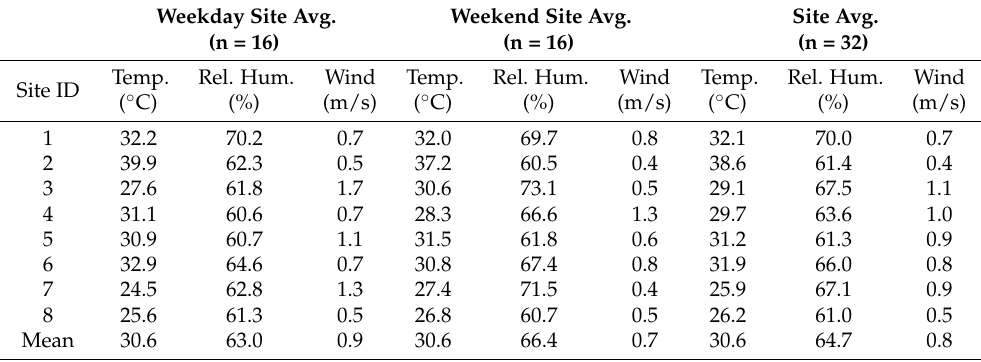
Table 4. Mean temperature, relative humidity, and wind speed at the sites. Weekday Site Avg. Weekend Site (n = 16)